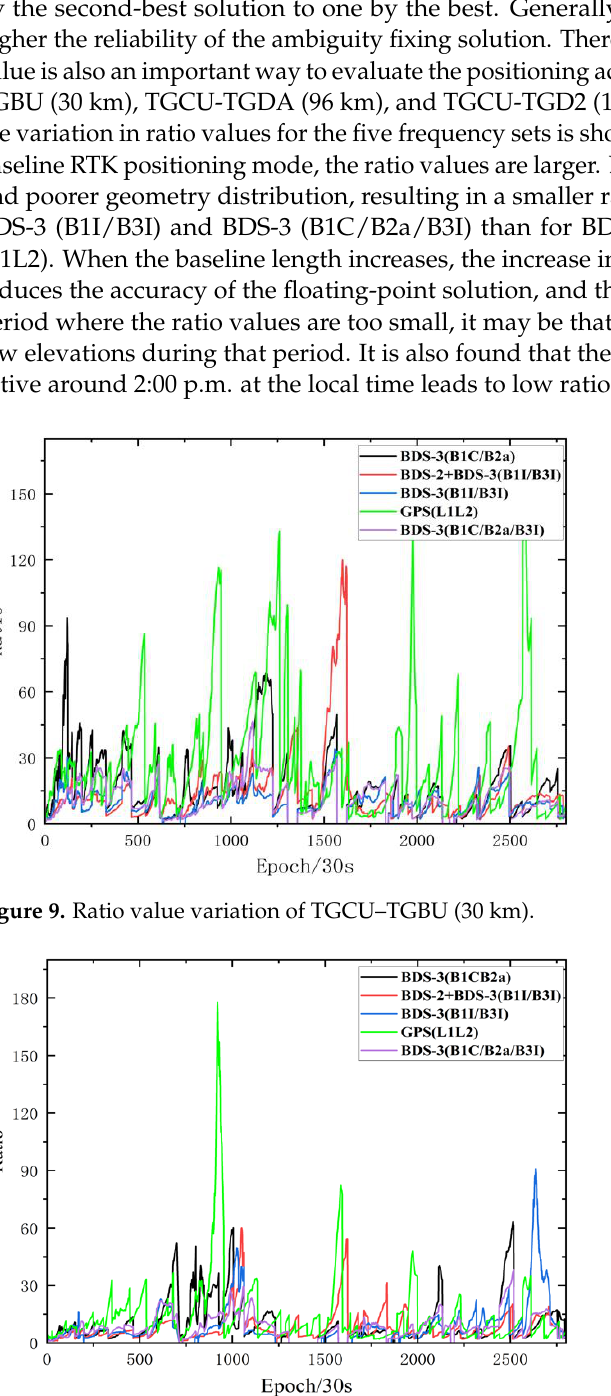
Figure 11. Ratio value variation of TGCU-TGD2 (128 km). 4.4. Time to First Fix Time to first fix is the time taken to initially fix the ambiguities, which is another indicator to evaluate the performance of RTK. Factors affecting the time to first fix of am- biguity include: the number of observation frequencies, PDOP, how fast the relative geo- metric configuration changes between the satellite and the receiver, observation accuracy,